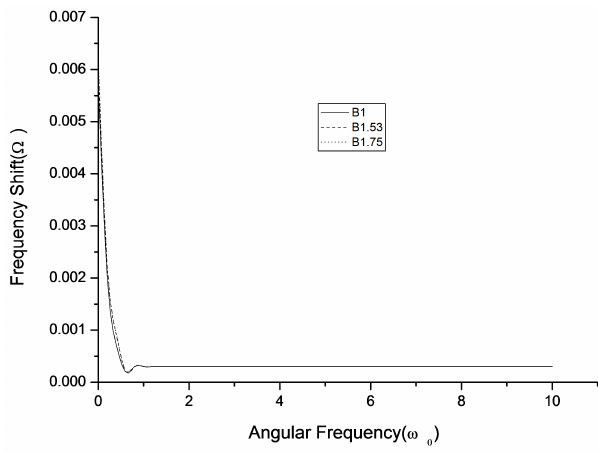
Figure 8: Variation in frequency shift with respect to angular fre- quency ( α = 0.75) .